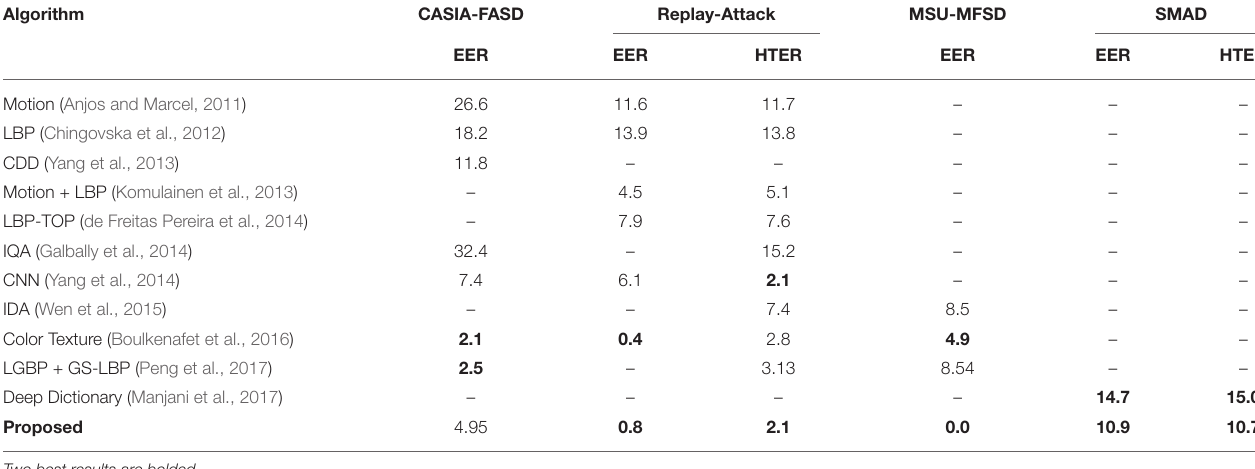
TABLE 8 | Comparison with SOTA results on the frame based presentation attack detection in terms of EEE (%) and HTER (%). Algorithm